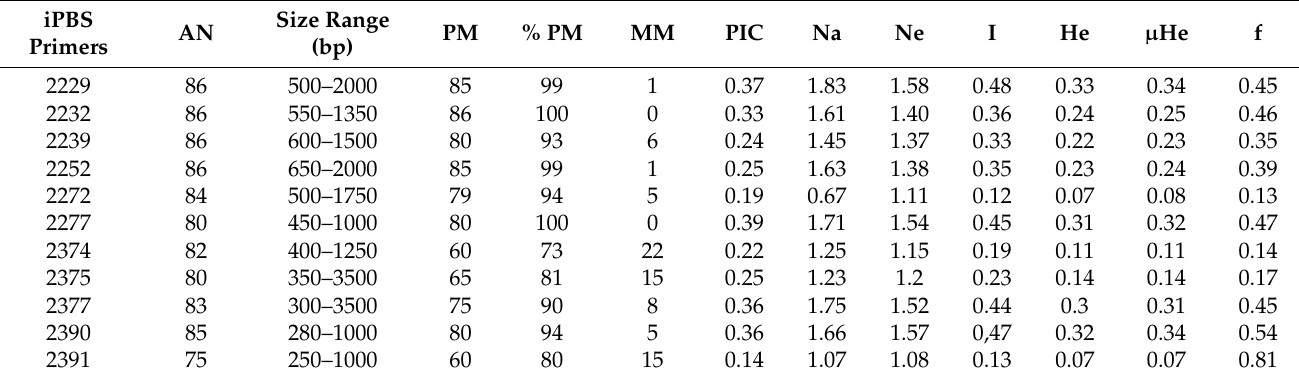
Table 3. Detection of polymorphism and summary statistics for mean values of 11 iPBS primers used